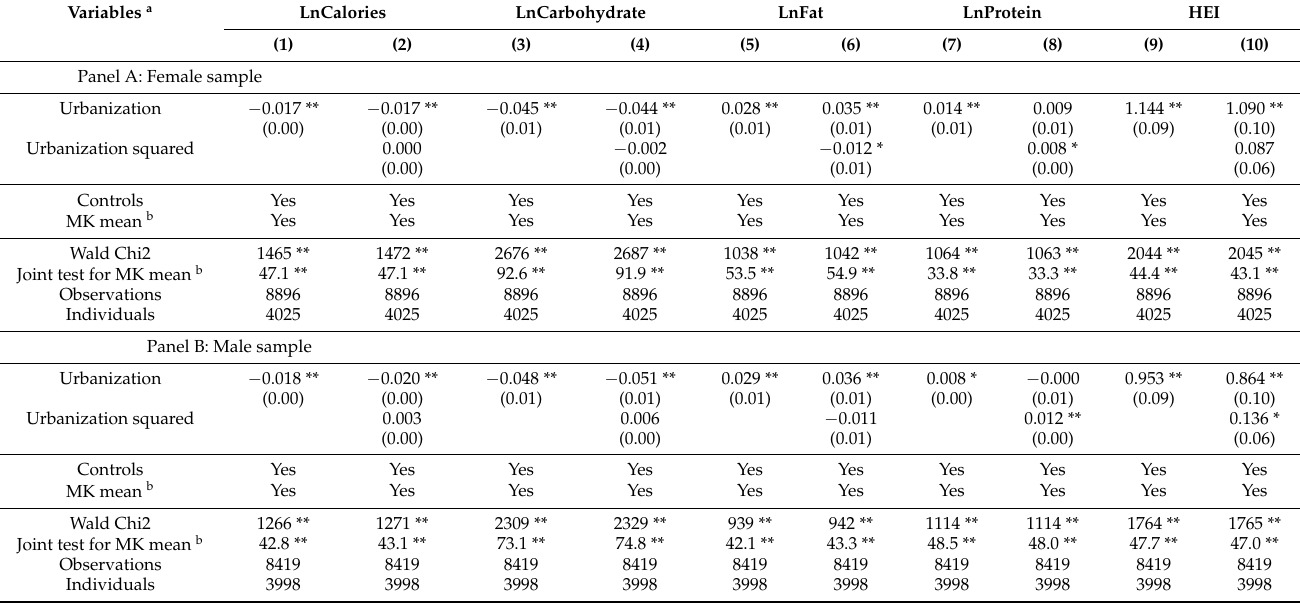
Panel A: Female sample